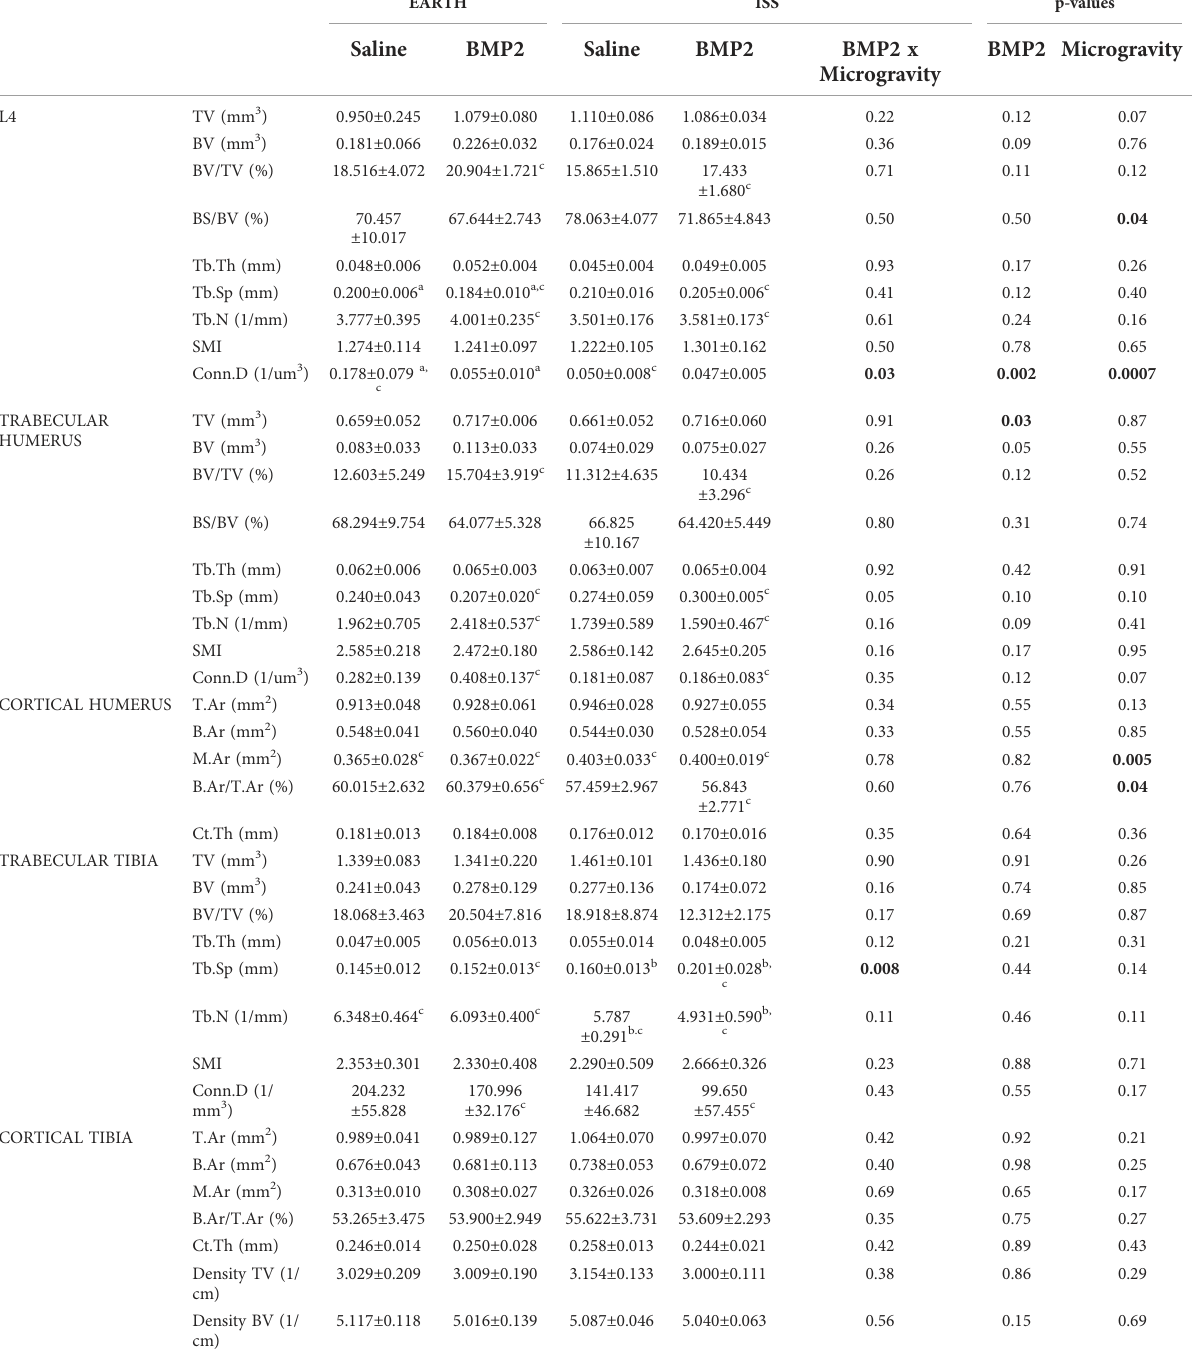
TABLE 2 m CT assessment of bone microarchitecture in weight bearing bones: fourth lumbar vertebrae (L4), humerus, and tibias, from mice housed both on Earth and at the International Space Station (ISS). EARTH ISS p-values Saline BMP2 Saline BMP2 BMP2 x